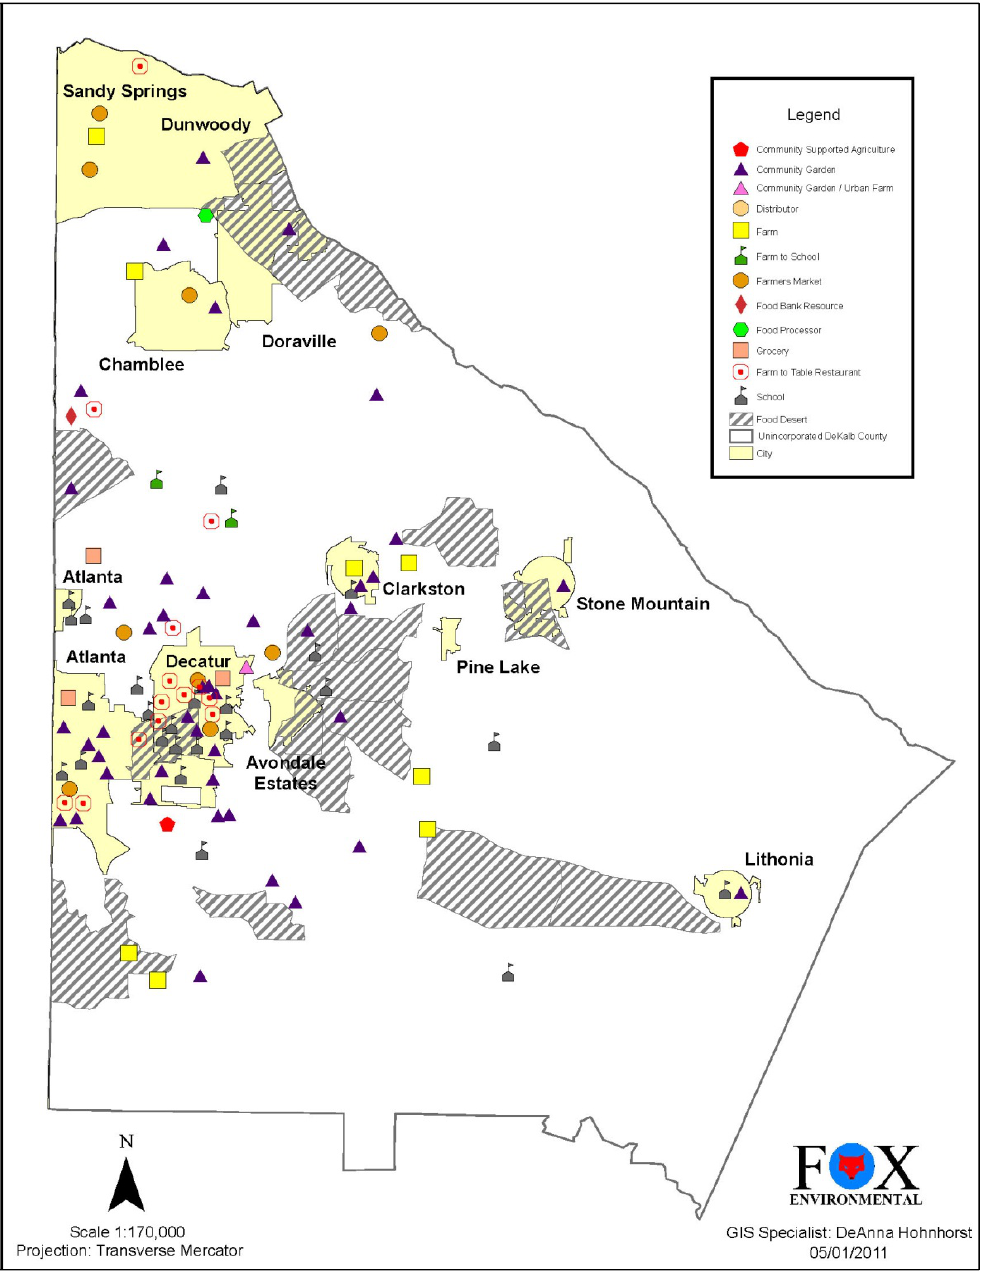
Figure 1. Map of Food Deserts and Local Food Resources in DeKalb